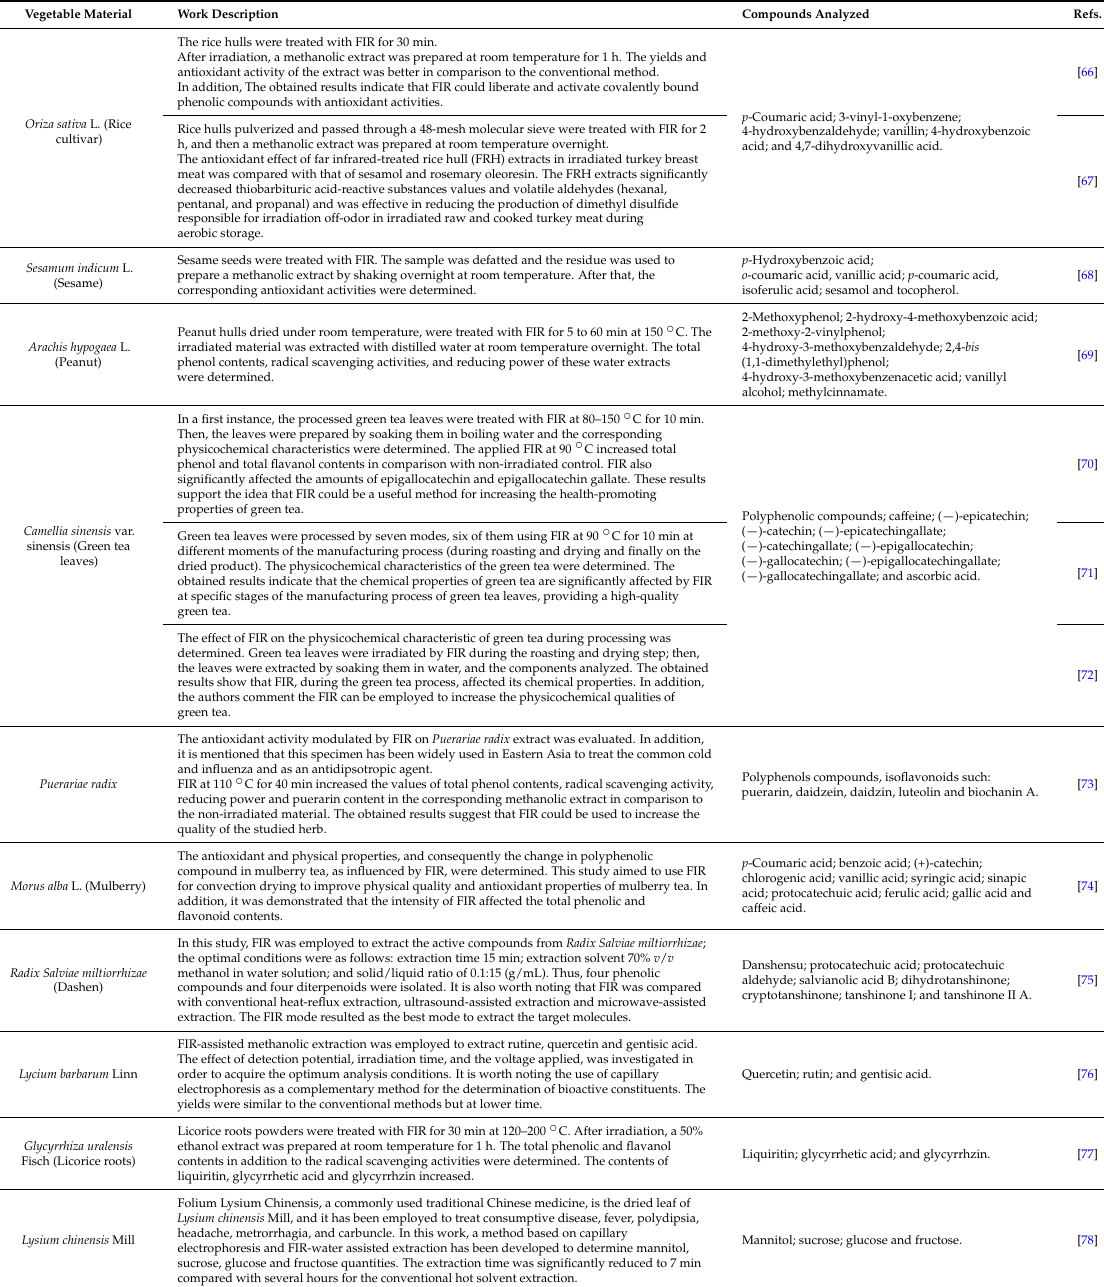
Table 2. Natural products extractions by infrared